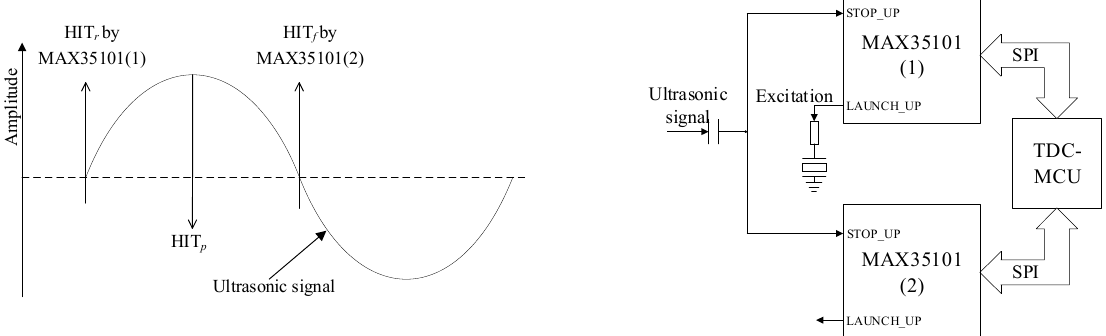
Figure 10. The dual-edge timing module.